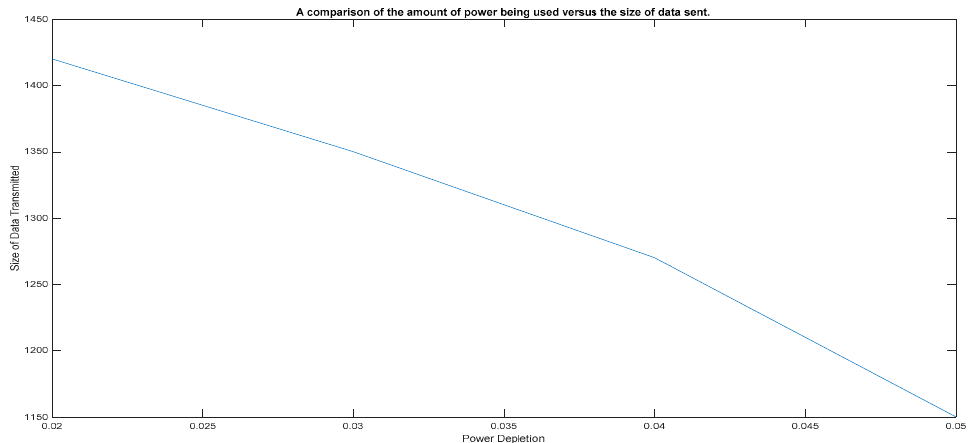
Figure 10. A comparison of the amount of power being used versus the size of data sent.